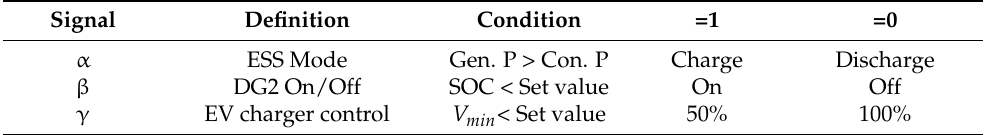
Table 1. Classification of three alarm signals for EMS